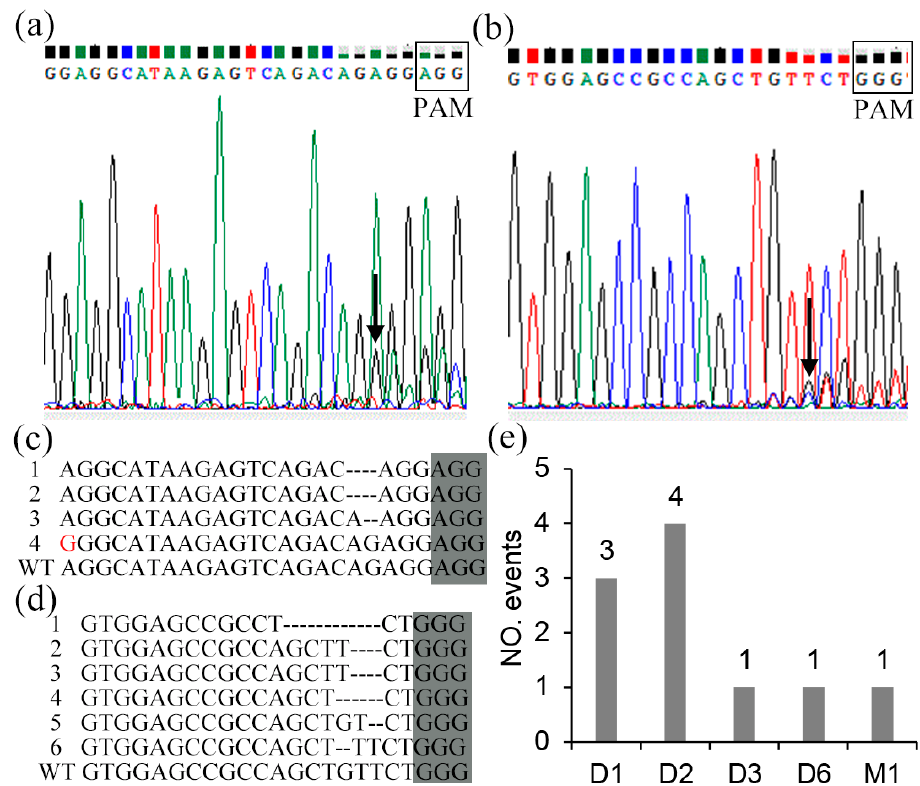
Figure 2. The detection of the CRISPR/Cas9-mediated mutation on the SDG102 target site in proto- plast, arrows indicated genomic DNA sequence was edited. ( a , b ) Direct sequencing of PCR products containing the targeted sites of the third exon and seventh exon, respectively. ( c , d ) Monoclonal mutation analysis of the targeted sites of the third exon and seventh exon, respectively. ( e ) Mutation- type analysis (D1 = 1 bp deletion; D2 = 2 bp deletion; D3 = 3 bp deletion; D6 = 6 bp deletion; M1 = nucleotide replacement mutation).